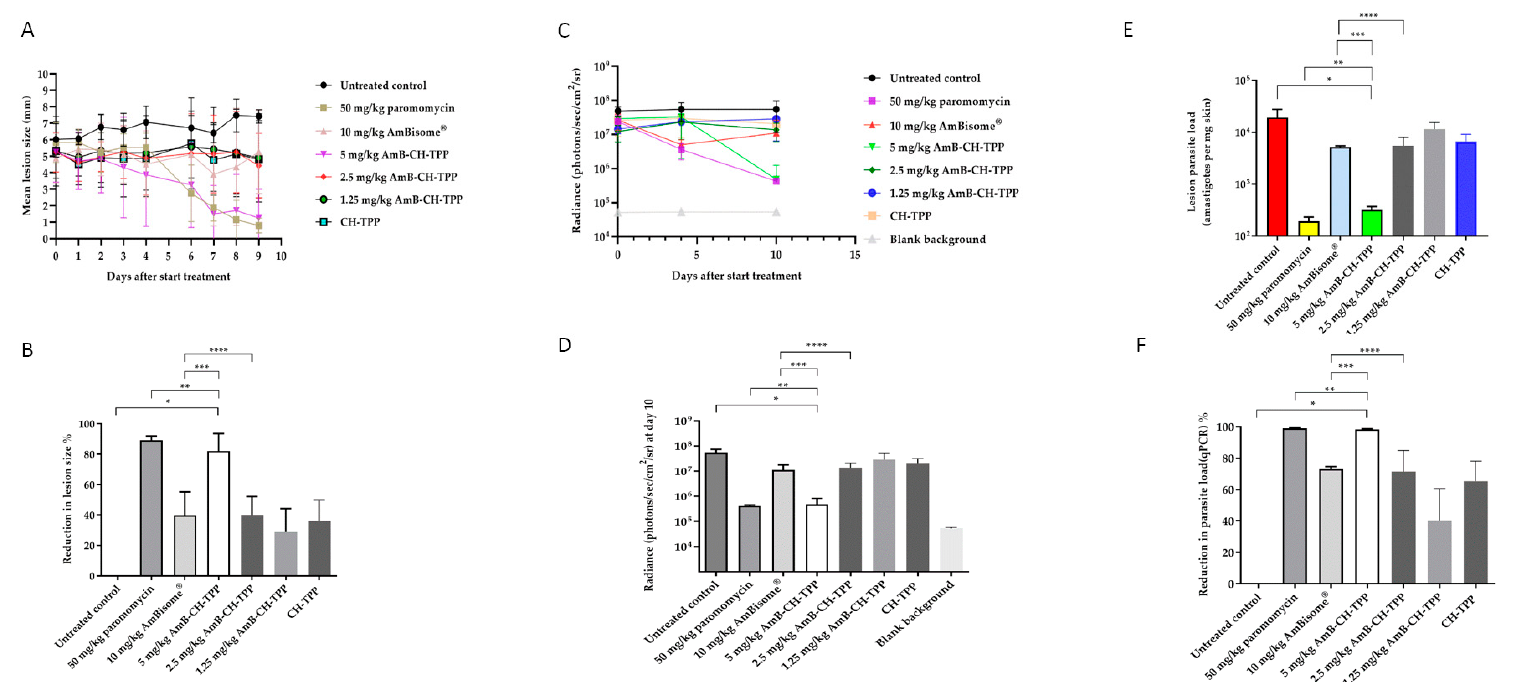
Figure 4. AmB nanoparticles efficacy in the lesion cure model in BALB/c mice infected with luciferase-expressing L. major parasites. L. major infected mice were allocated into 7 groups: (G1) represents untreated infected group, (G2) paromomycin as a positive control (50 mg/kg/QD for 10 days; i.p.), (G3) AmBisome ® as a comparison group (10 mg/kg/QAD for 10 days; i.v.), (G4) AmB-CH-TPP nanoparticles (5 mg of AmB/kg/QAD for 10 days; i.v.), (G5) AmB-CH-TPP nanoparticles (2.5 mg of AmB/kg/QAD for 10 days; i.v.), (G6) AmB-CH-TPP nanoparticles (1.25 mg of AmB/kg/QAD for 10 days; i.v.) and (G7) CH-TPP nanoparticles (nanoparticles mass being equivalent to that in animals receiving the 5 mg/kg dose) (QAD for 10 days; i.v.). The average lesion size and parasite load represent the mean ± SD. One-way-ANOVA for parasite load (bioluminescence signal), parasite load (qPCR) and repeated measures for lesion size followed by Tukey’s multiple-comparison tests was used to compare outcomes among the groups. A p -value < 0.05 was considered statistically significant ((*) p < 0.05, (**) p > 0.05, (***) p < 0.05 and (****) p > 0.05). ( A ) represents mean lesion size progression in function of time since the start of treatment, ( B ) represents the % reduction in lesion size compared with G1 (untreated infected group) at day 10, ( C ) represents the bioluminescence signal in function of time since the start of treatment, ( D ) represents the bioluminescence signal compared with G1 (untreated infected group) at day 10, ( E ) represents the parasite load (qPCR-DNA) at day 10 and ( F ) represents the % reduction in the parasite load (qPCR) compared with G1 (untreated infected group) at day 10.